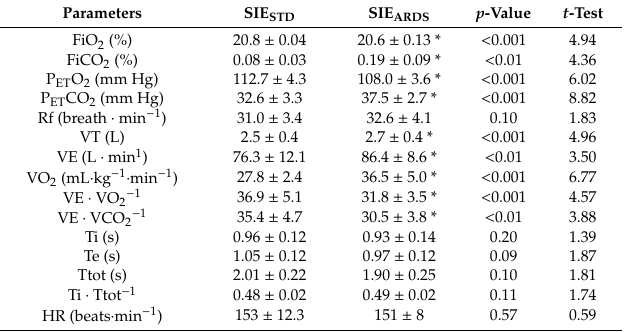
Table 2. Comparison of mean ( x ± SD) physiological responses between both SIE